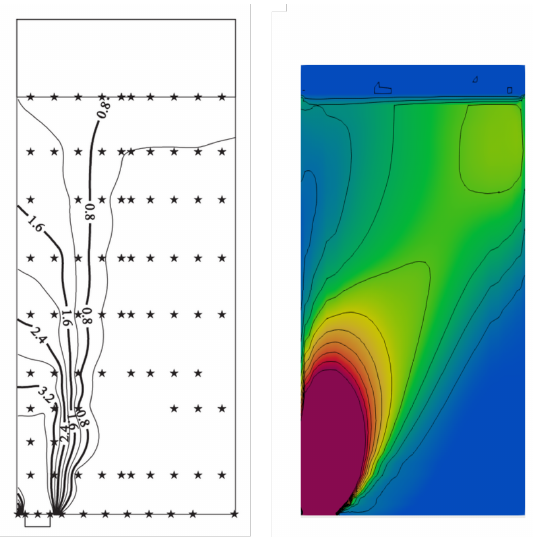
Figure 7. Silo discharge for Test 2 showing contour lines for equal values of the velocity magnitude: Experimental results (left) and the CFD simulation